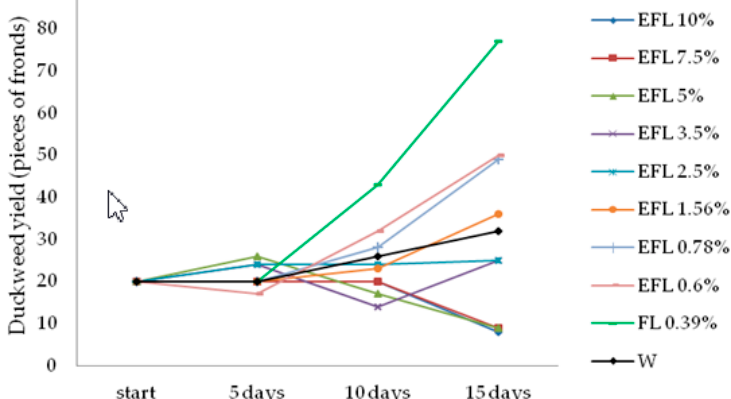
Figure 2. Yield of duckweed cultured on growth media with different concentrations of the effluent from the biorefinery (EFL).